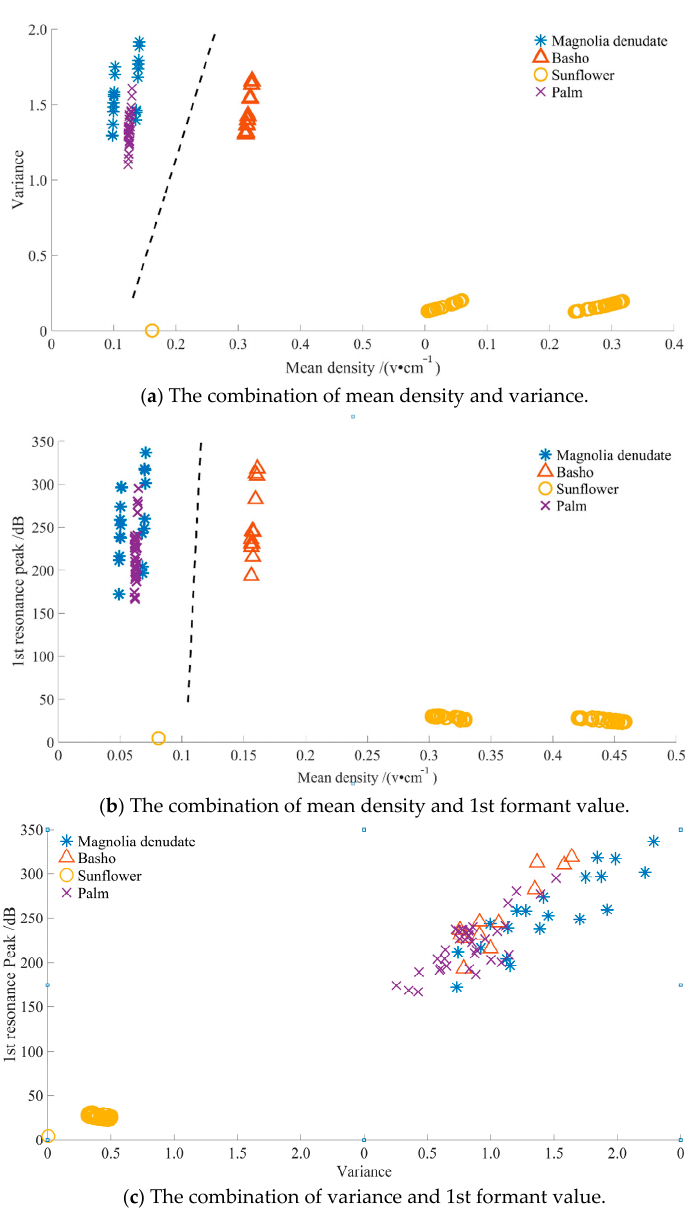
Figure 6. Differential identification of plant stems based on feature combination.